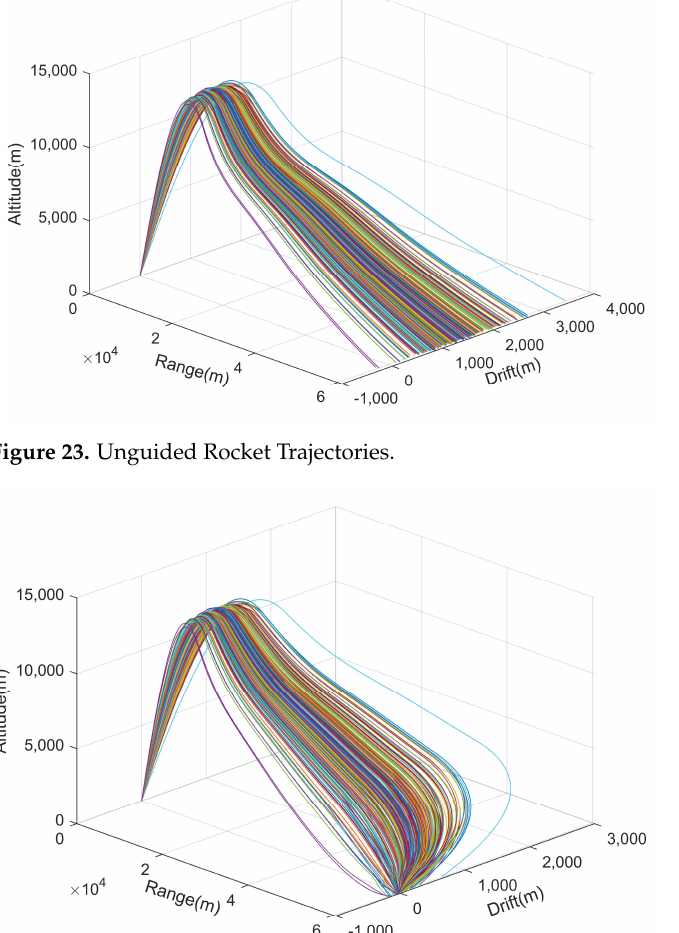
Figure 25. Unguided Rocket CEP. 5.8